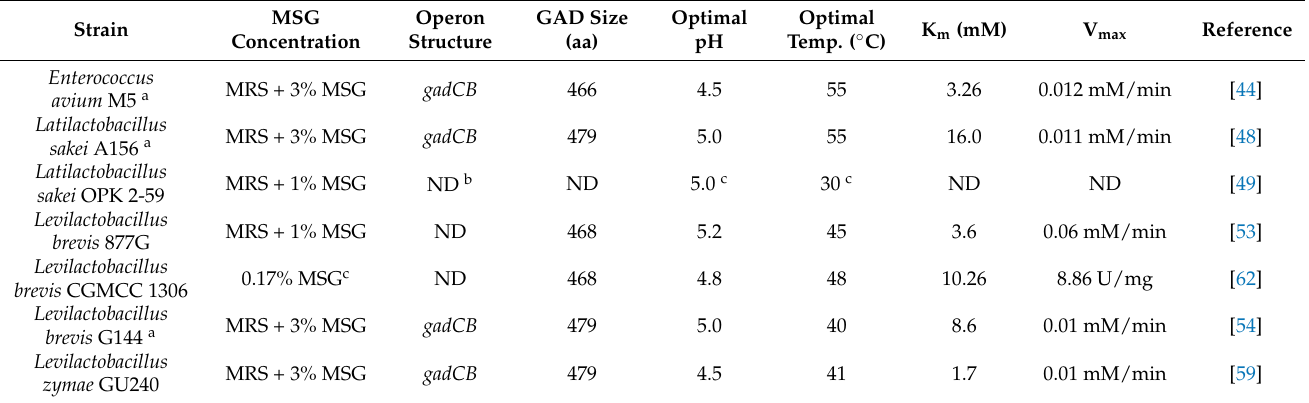
Table 3. Properties of purified GADs from LAB isolated from kimchi or